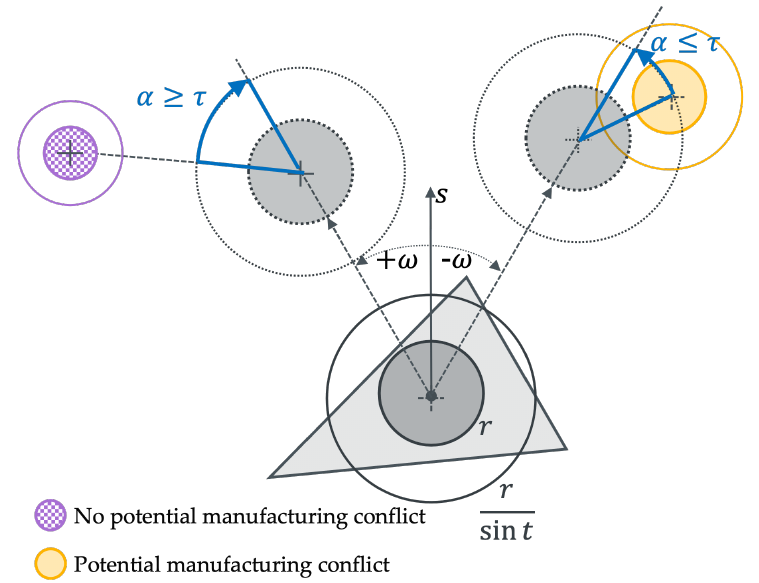
Figure 3. The finite-sphere that simplifies the actual shape of a tetrahedral element is noted in grey. Elements without a potential manufacturing conflict are noted in violet and elements with a potential manufacturing conflict are noted in orange. Adapted from [2].